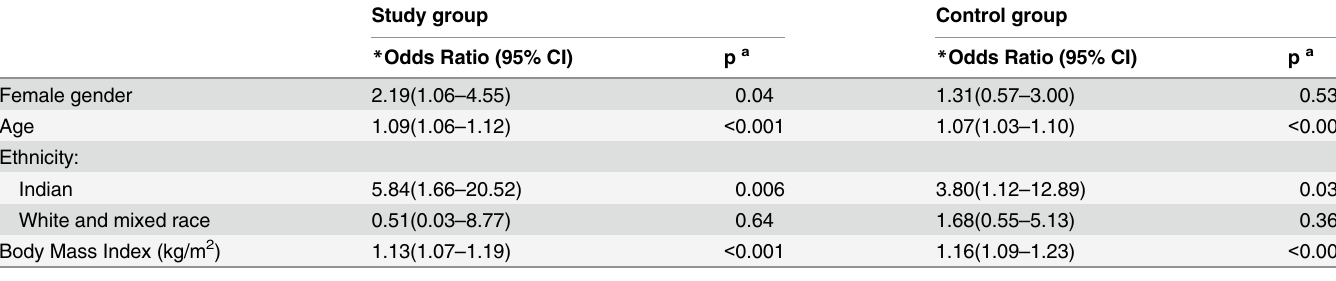
Table 6. Multivariate analysis of risk factors associated with metabolic syndrome in the study and control